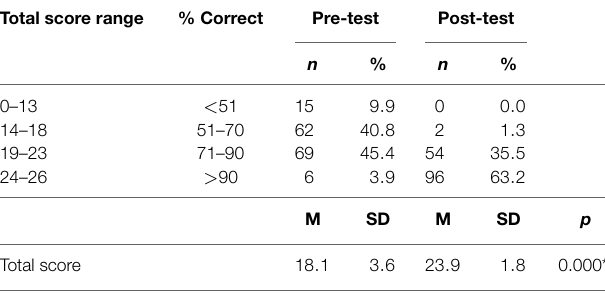
FIGURE 1 | Distribution of the total score before and after the workshop